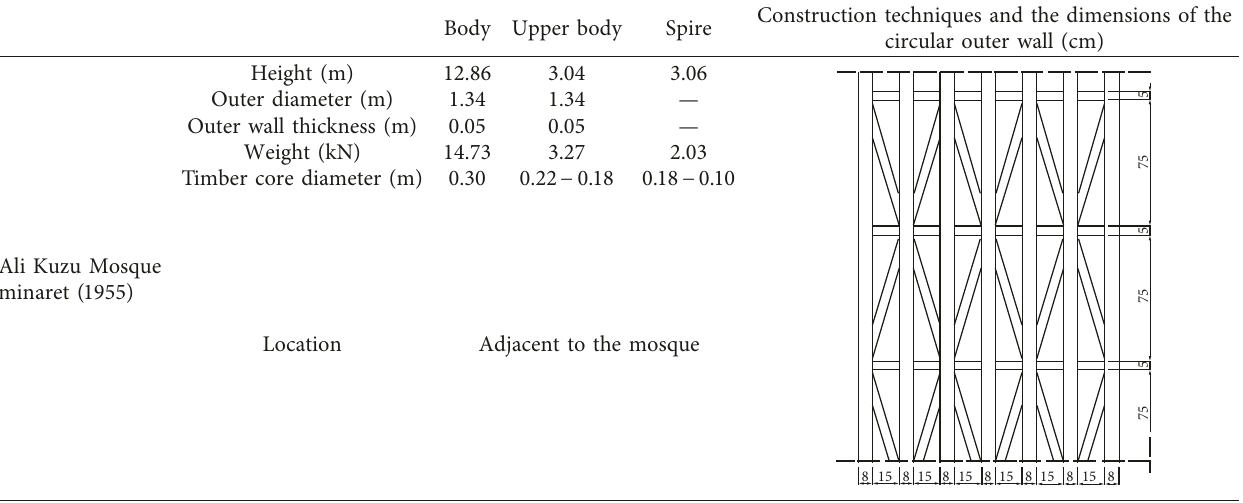
Table 4: The geometric properties and construction techniques of the Ali Kuzu Mosque minaret. Construction techniques and the dimensions of the Body Upper body Spire circular outer wall (cm)